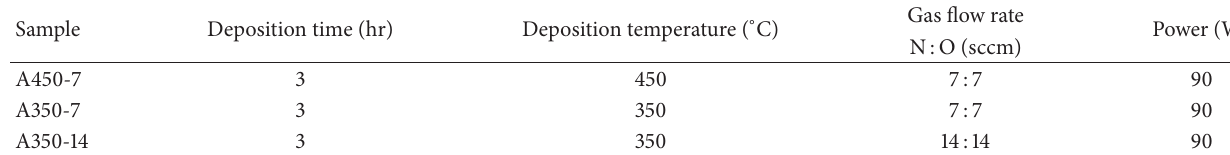
Table 1: Deposition conditions for the Al-doped ZnO thin film samples.